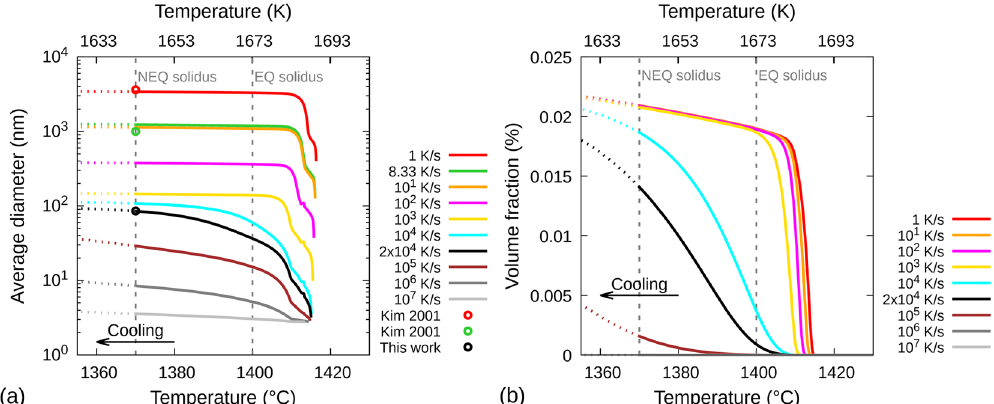
Figure 9. M–S precipitation kinetics simulation predicted (a) average diameter (log scale) and (b) volume fraction as a function of temperature during solidification/cooling at different temperature rates. ‘EQ solidus’ and ‘NEQ solidus’ respectively stand for the equilibrium and non-equilibrium solidus temperatures; the latter (1643 K) is obtained from Dépinoy et al. 30 The black curves in (a,b) correspond to approximately the average cooling rate obtained from Fig. 7 between 1273 and 1673 K. The red and green empty circles in (a) represent the M–S precipitate diameters reported by Kim et al. 16 for cooling rates 1 K/s and 8.33 K/s, respectively. The black empty circle represents the non-oxide inclusion diameter in mixed precipitates obtained from Fig. 6. Gnuplot v5.4 (http:// www. gnupl ot. info) was used to prepare this